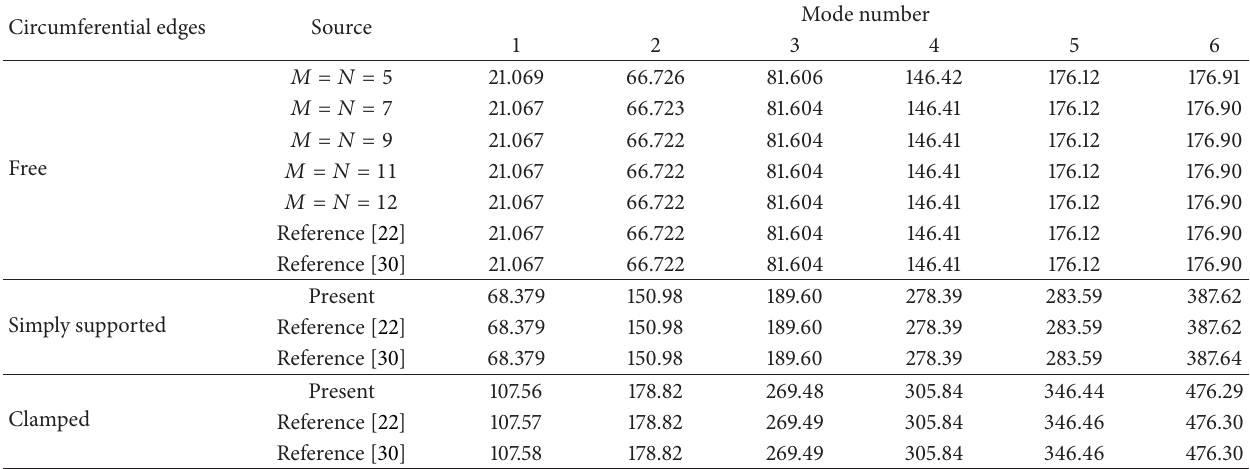
Table 2: Frequency parameters, Ω = 𝜔𝑏 2 (𝜌ℎ/𝐷) 1/2 , for an annular sector plate with radial edges simply supported ( 𝑎/𝑏 = 0.5, 𝜙 = 𝜋/4 , and 𝜇 = 0.3 ).